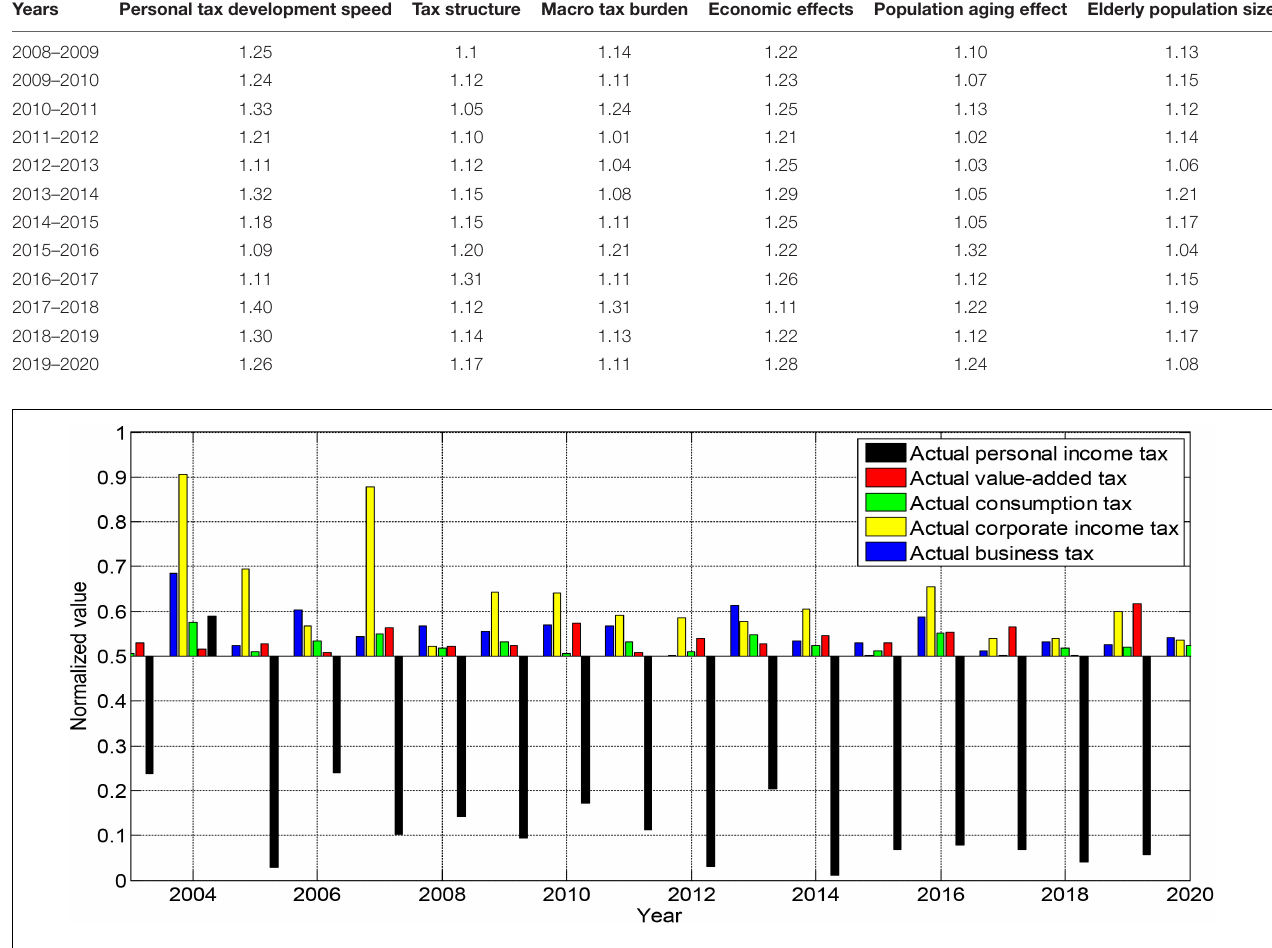
TABLE 2 | Decomposition results of the development speed of national personal tax revenue. Years